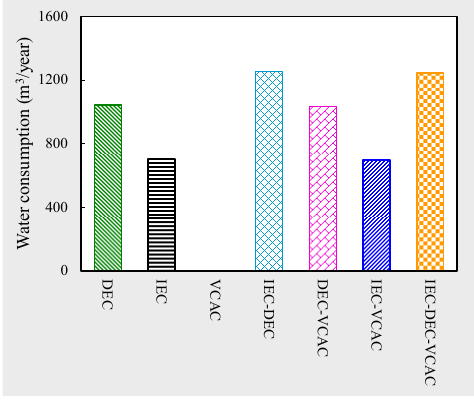
Figure 11. Variation in ( a ) Cooling capacity, ( b ) work input, and ( c ) COP of the seven AC configurations in summer.